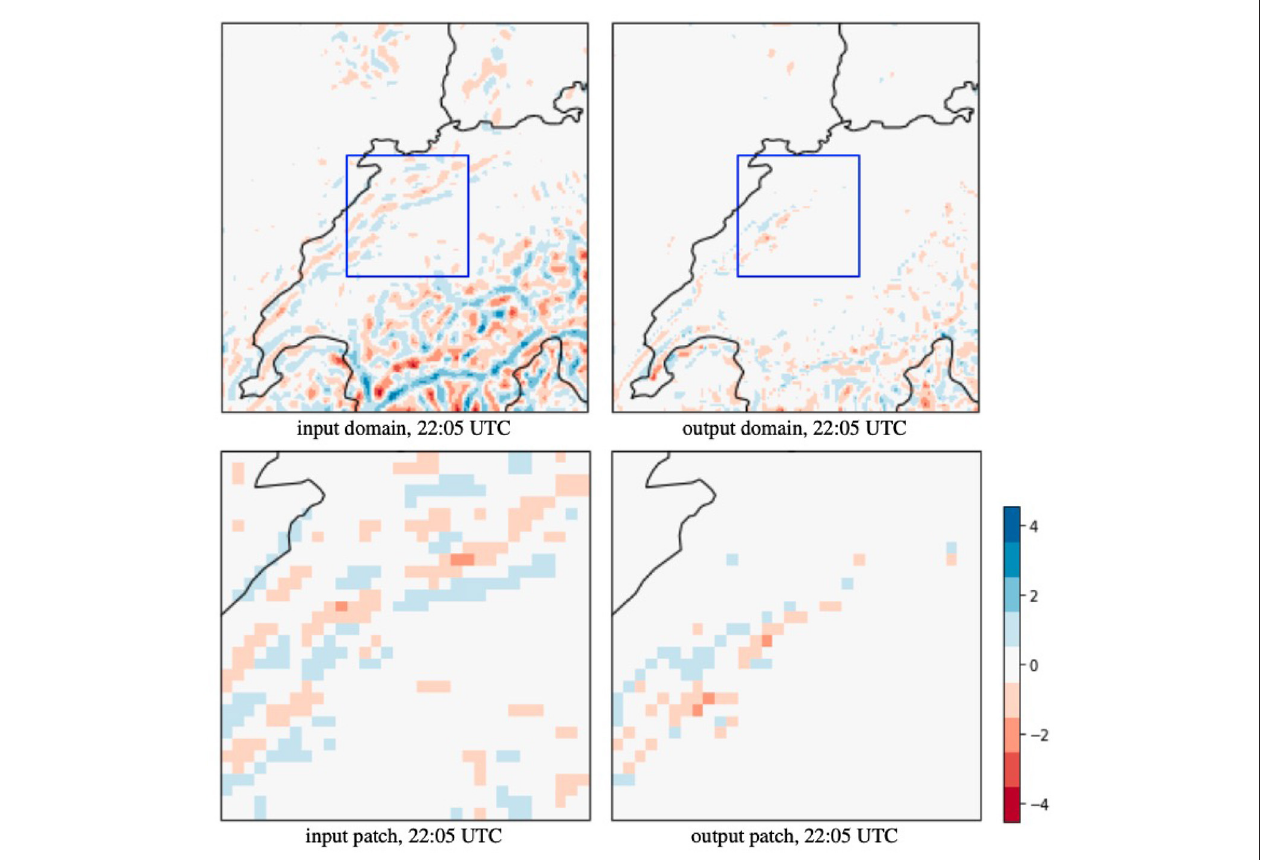
FIGURE 5 | The error map of Figure 4 in MSE ( ◦ C) shows a comparison between the trilinear interpolated input and our predicted output relative to the groundtruth. On the full domain, RPN reduces the MSE from 1.438 to 0.143 ◦ C which is a 10 × improvement, and on the zoom-in (blue box), the MSE reduced from 0.533 to 0.077 ◦